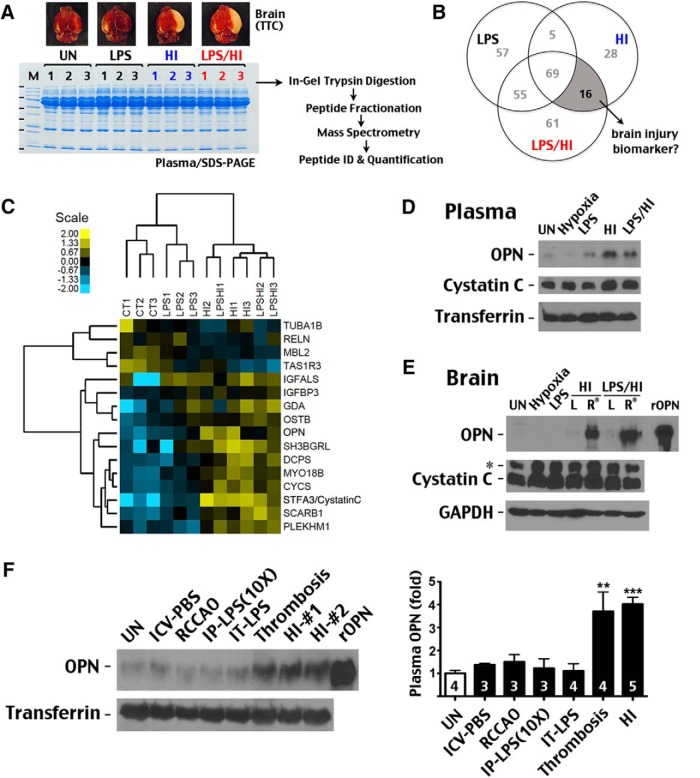
Proteomic analysis of plasma biomarkers for murine neonatal HI brain injury. A, Plasma proteins collected from unchallenged (UN), low-dose LPS (0.3 mg/kg, IP)-exposed, and HI- or LPS/HI-injured P11 mice were separated by SDS-PAGE and analyzed as depicted (n = 3 for each). Also shown are representative tetrazolium chloride–stained brains in each group, showing cerebral infarction (pale color) in only HI- or LPS/HI-injured animals. B, Venn diagram showing the number of unique proteins in the depicted conditions compared with the unchallenged animals. C, Heatmap and hierarchical clustering of the 12 examined animals based on the signal intensity of HI- and LPS/HI-associated proteins. Shown is the log2 scale of fold change. D, E, Immunoblot showing specific OPN induction in plasma and the ipsilateral hemisphere (right, R*) of mice after HI or LPS/HI insult. In contrast, although cystatin C showed increased plasma levels after HI and LPS/HI injury, it was not elevated in the brain after these injuries. *, Nonspecific anti–cystatin C band in the brain. rOPN, recombinant mouse OPN used as positive control. F, Immunoblotting showing that cerebral stroke (thrombosis) also induced high levels of plasma OPN, whereas ICV injection of phosphate saline (ICV-PBS), unilateral carotid artery ligation (RCCAO), i.p. injection of 3 mg/kg LPS (IP-LPS[10×]), and intratracheal application of 0/3 mg/kg LPS (IT-LPS) lacked this effect. The numbers of mouse pups examined in each condition are indicated. **, p < 0.01; ***, p < 0.001 by t-test compared with unchallenged animals.